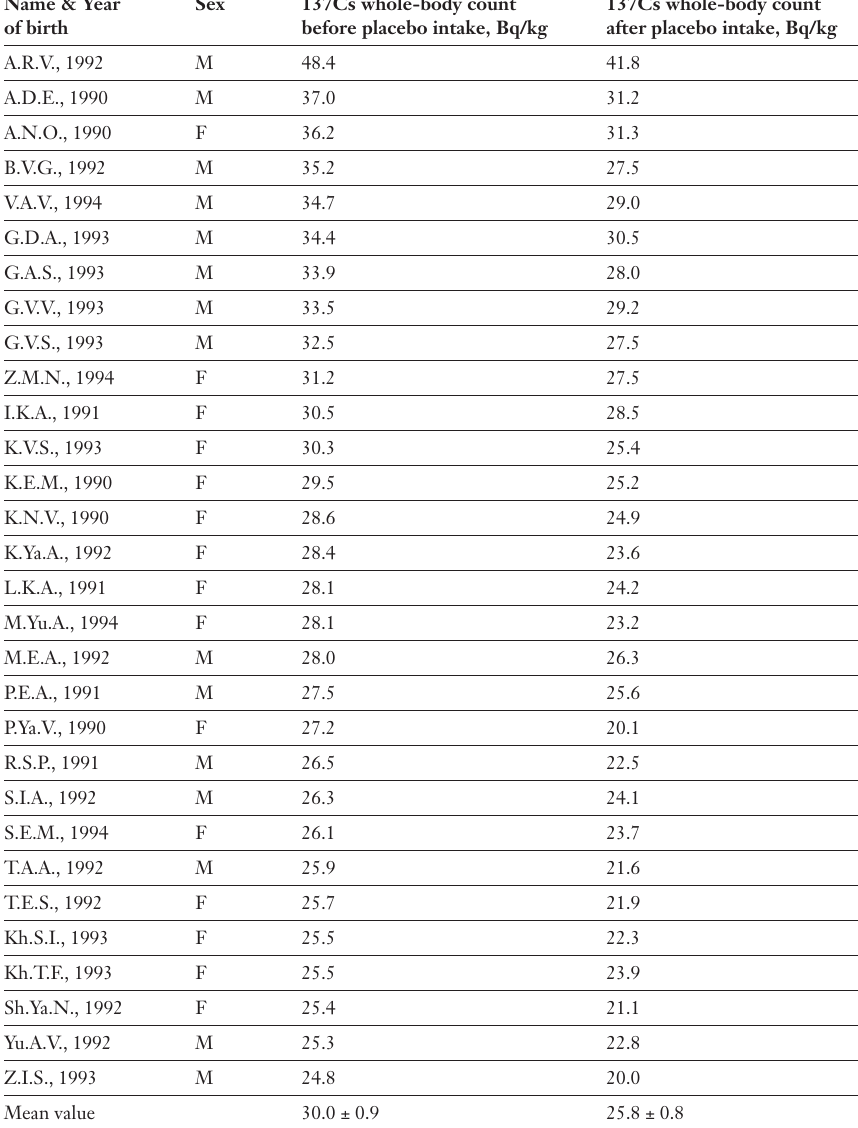
Table 2 The mean decrease was 62.6% in the pectin-treated group. Comparison of the 137Cs whole-body count (Bq/kg body- weight) in children before and after a 3 week placebo